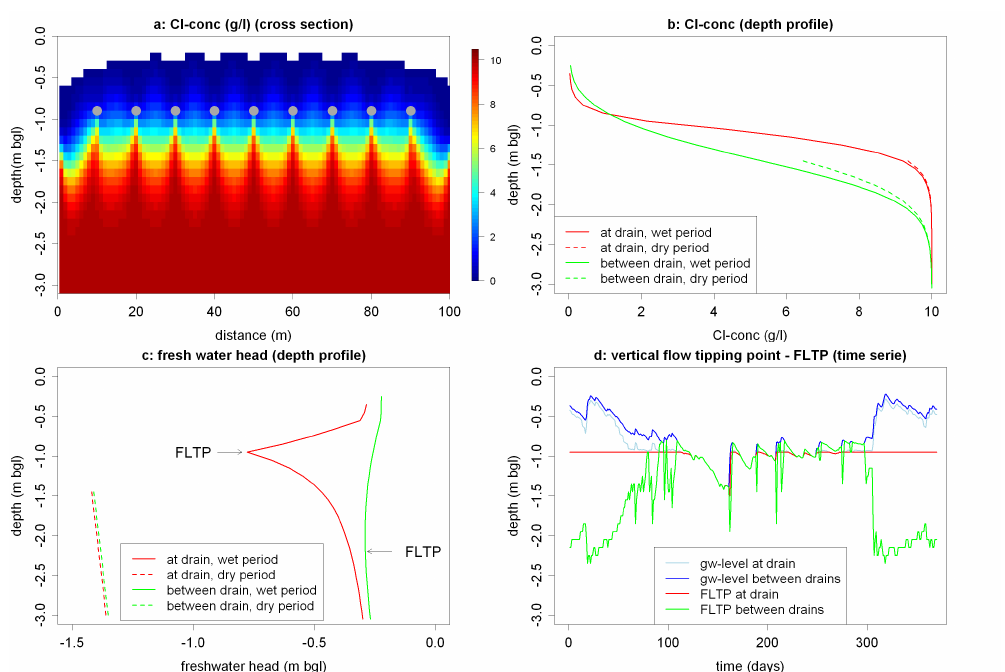
Fig. 11. Model results of the reference 2-D-model. (a) Cl-concentration in cross-section between two ditches (wet period). (b) Cl-conc. – depth profile for a location at and between drains (wet and dry period). (c) Freshwater head depth profile for location at and between drains (wet and dry period). (d) Time series of vertical flow tipping point (FLTP) and groundwater level for a location at and between drains.